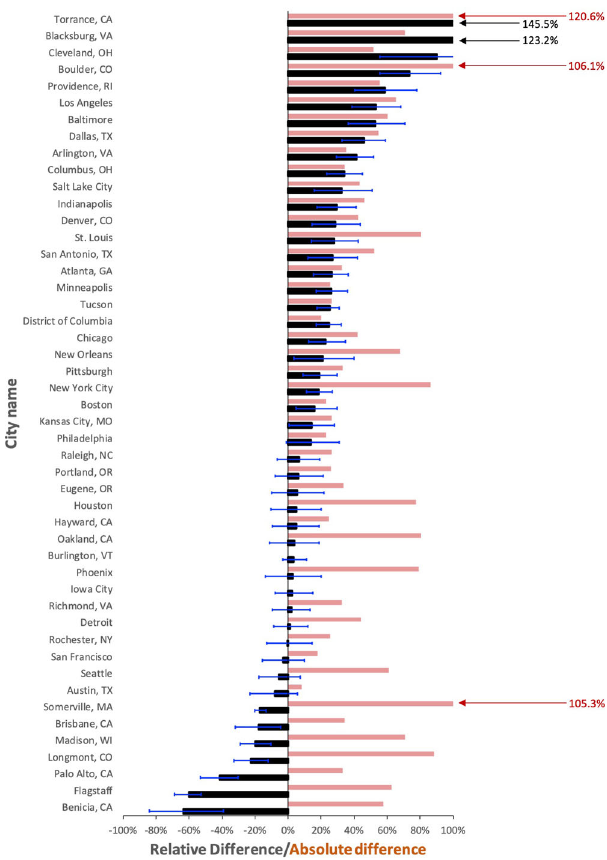
Fig. 2 Sector-based individual city ( N = 48) FFCO 2 emissions relative difference (RD) between the Vulcan version 3.0 urban FFCO 2 emissions and self-reported inventories (SRIs). Black: total emissions RD; error bars: total emissions RD range from Vulcan 95% con fi dence interval; red: mean across-sector absolute relative difference (MASAD). RD calculated as [(Vulcan – SRI)/mean(Vulcan, SRI)]. Scale capped at 100%. Not all sector categories available in all cities; where individual sectors were missing in the SRIs, the mean only includes those available in both Vulcan and SRI results (see “ Methods ” and Source data for additional details).